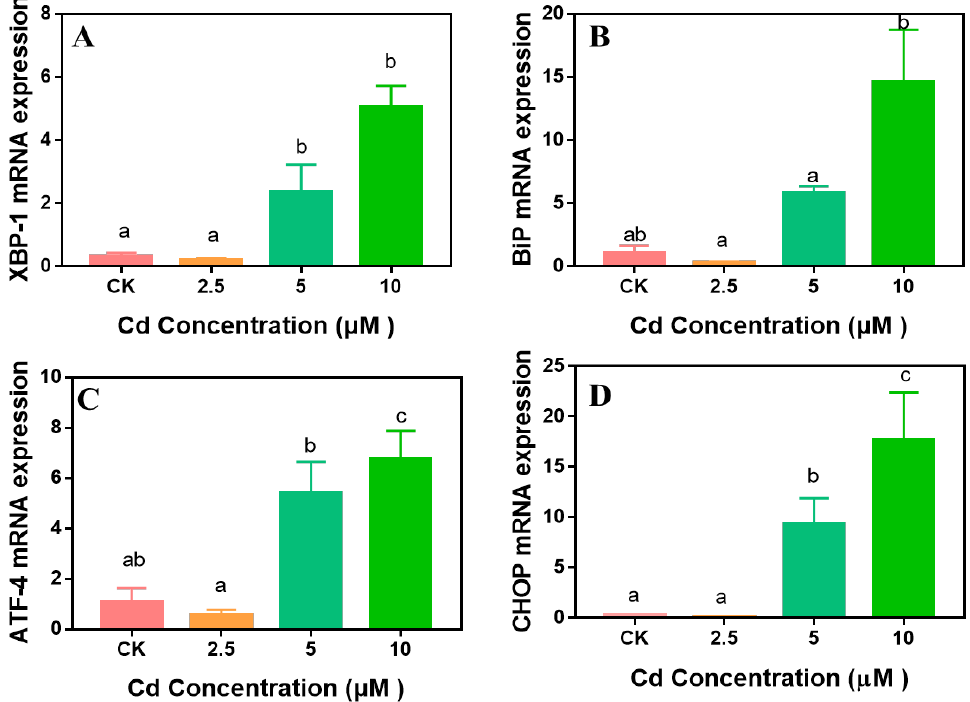
Figure 6. Expression of endoplasmic reticulum (ER) stress-related genes ( A – D ) in HaCaT cells after exposure to 2.5–10 µ M Cd for 24 h. Results are presented as mean ± SE of three independent experiments. The different letters above the columns indicate a significant difference at p < 0.05.